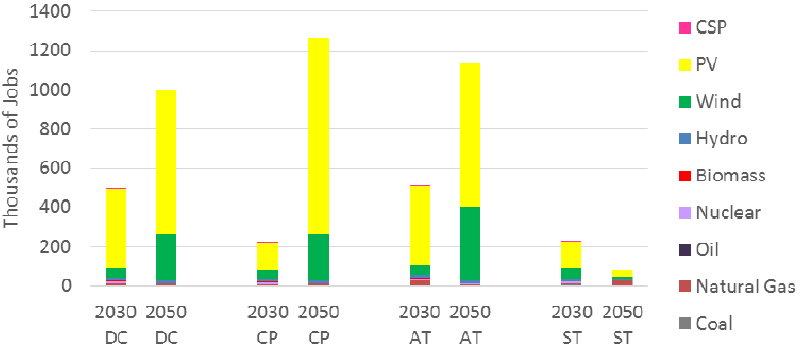
Figure 16. Employment generation of Spain’s electricity system: future projections.